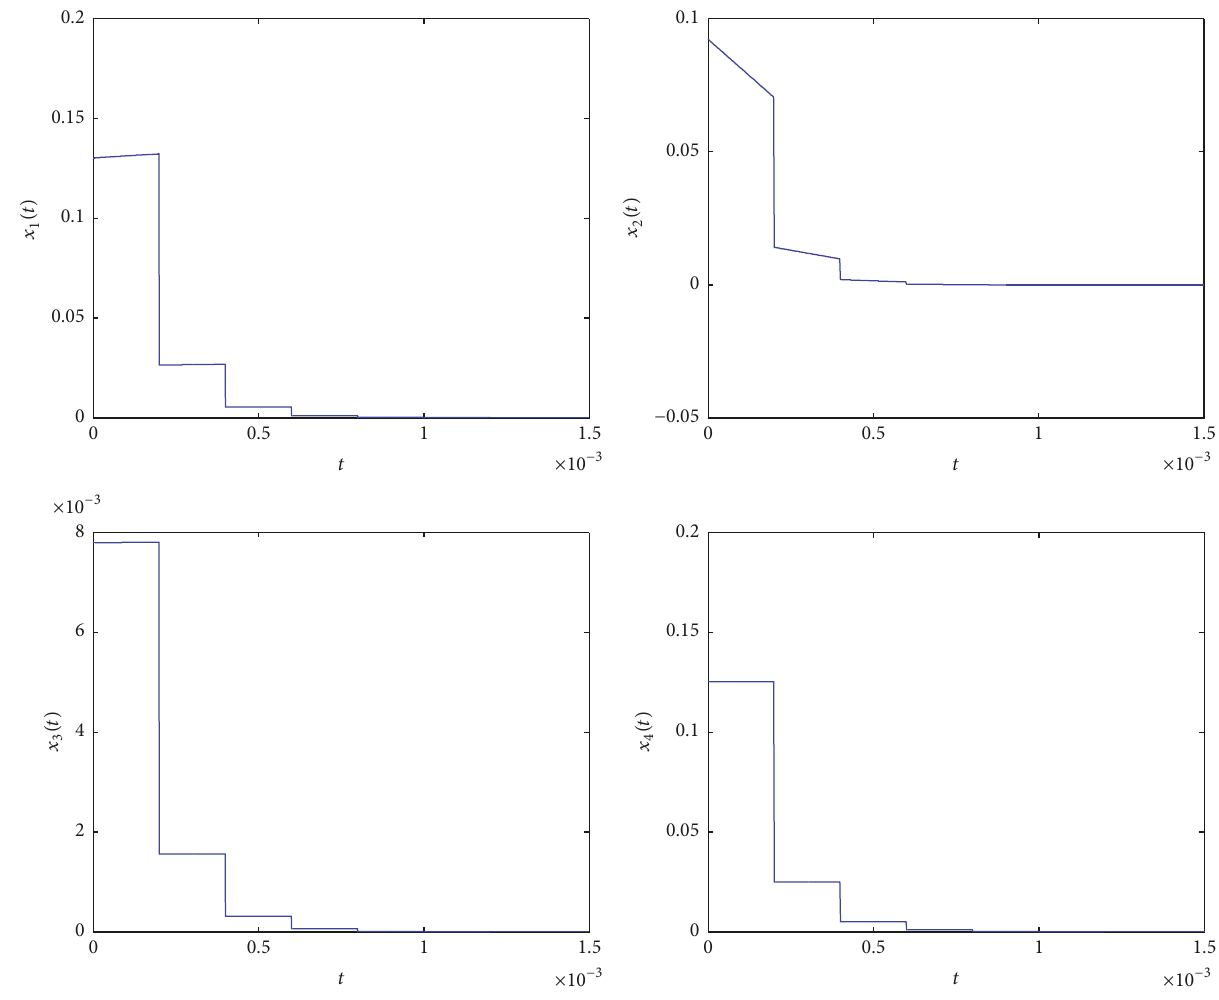
Figure 3: The state trajectory of the controlled memristor based chaotic